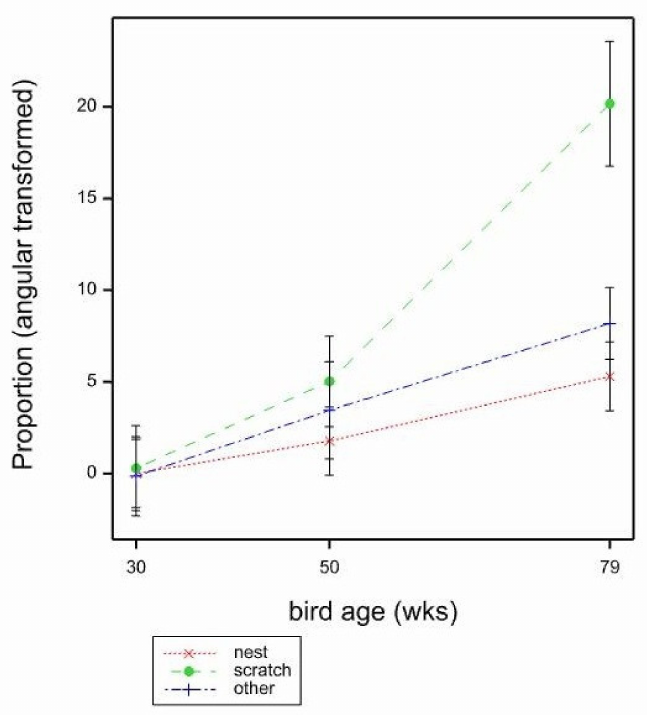
Figure 7. Mean proportions (angular transformed) of dirty eggs per location by bird age by location in the cage (nest, scratch mat, all other areas) estimated from LMM. Mean SE 3.219. With the proportion of cracked eggs per location, there was a significant effect of age ( p < 0.001 by GLMM, 30 weeks − 5.256, 50 weeks − 4.905, 79 weeks − 2.942, Mean SE 0.3983, Wald 2 = 49.07, back transformed 30 weeks 0.005, 50 weeks 0.007, 79 weeks 0.050) with a higher proportion of cracked eggs per location seen at 79 weeks. There was no significant effect of location or mat type. With interactions, all GLMMs failed, but LMMs indicated some significant interactions. There was a significant bird age × location effect ( p = 0.016, by LMM, F 4,267 = 3.11, mean SE 1.465) with a greater proportion of cracked